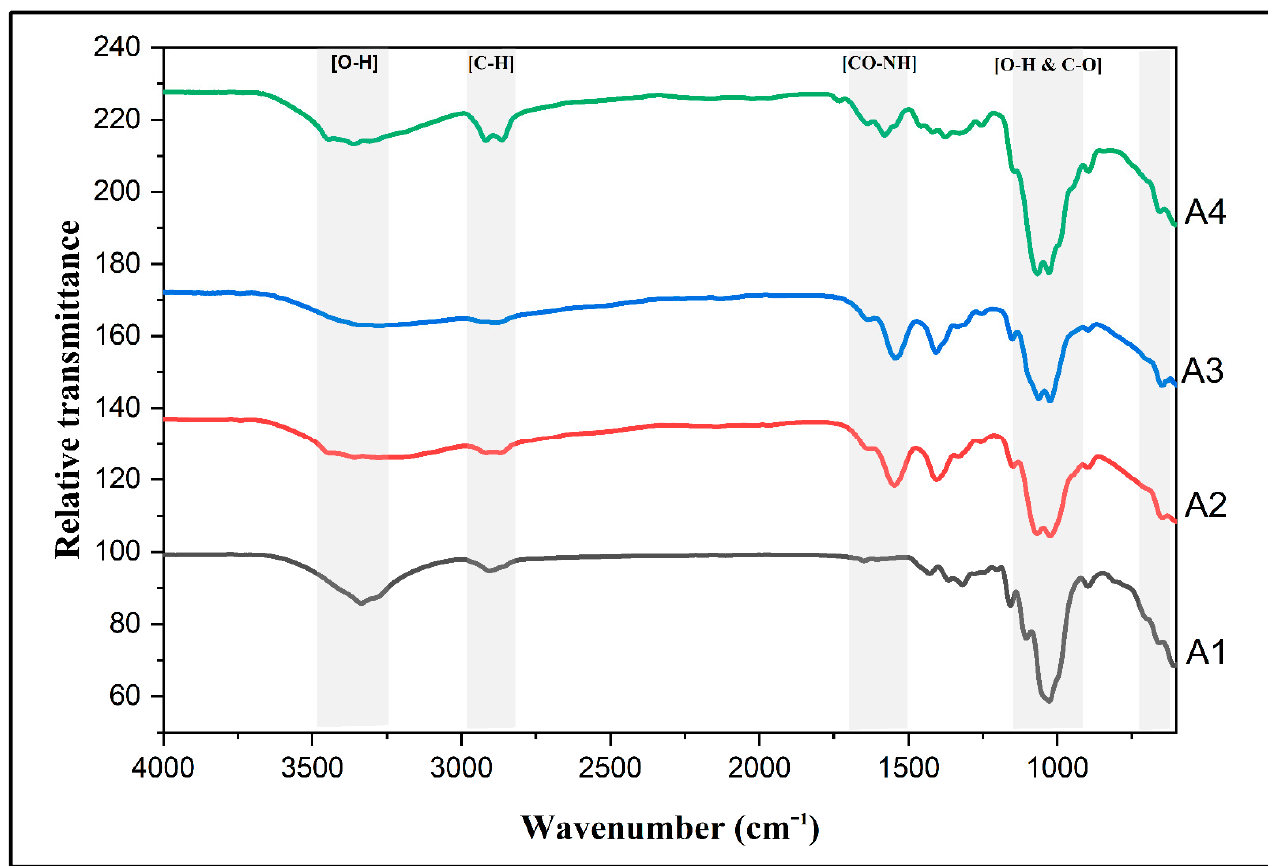
Figure 3. Fourier-transform infrared (FTIR) spectra of prepared aerogel samples.